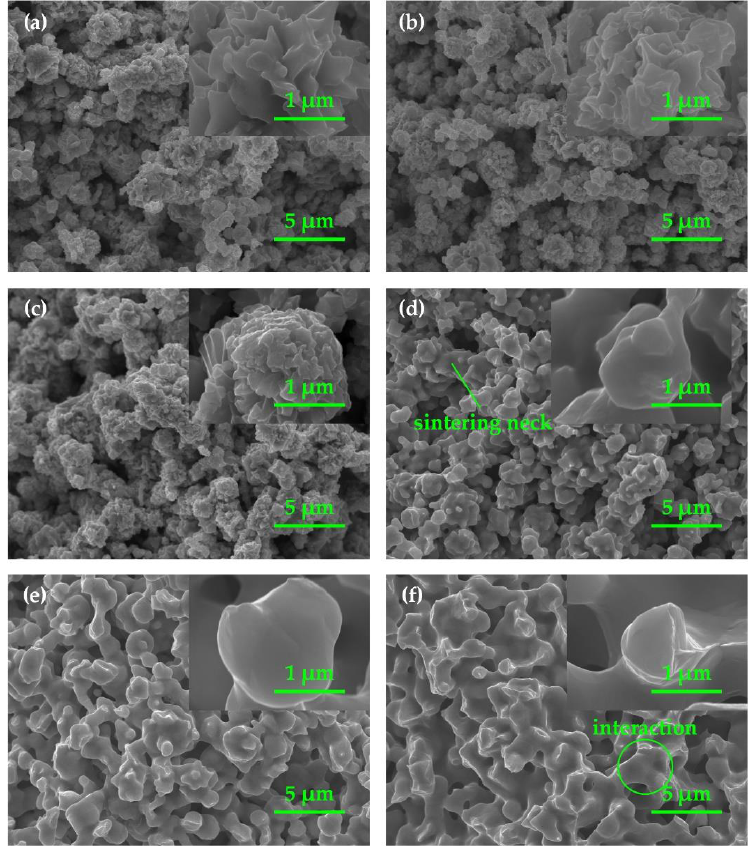
Figure 4. Fracture morphology of green slices and wicks sintered at different temperatures: ( a ) green slice, ( b ) 200 °C, ( c ) 300 °C, ( d ) 400 °C, ( e ) 500 °C, ( f ) 600 °C.